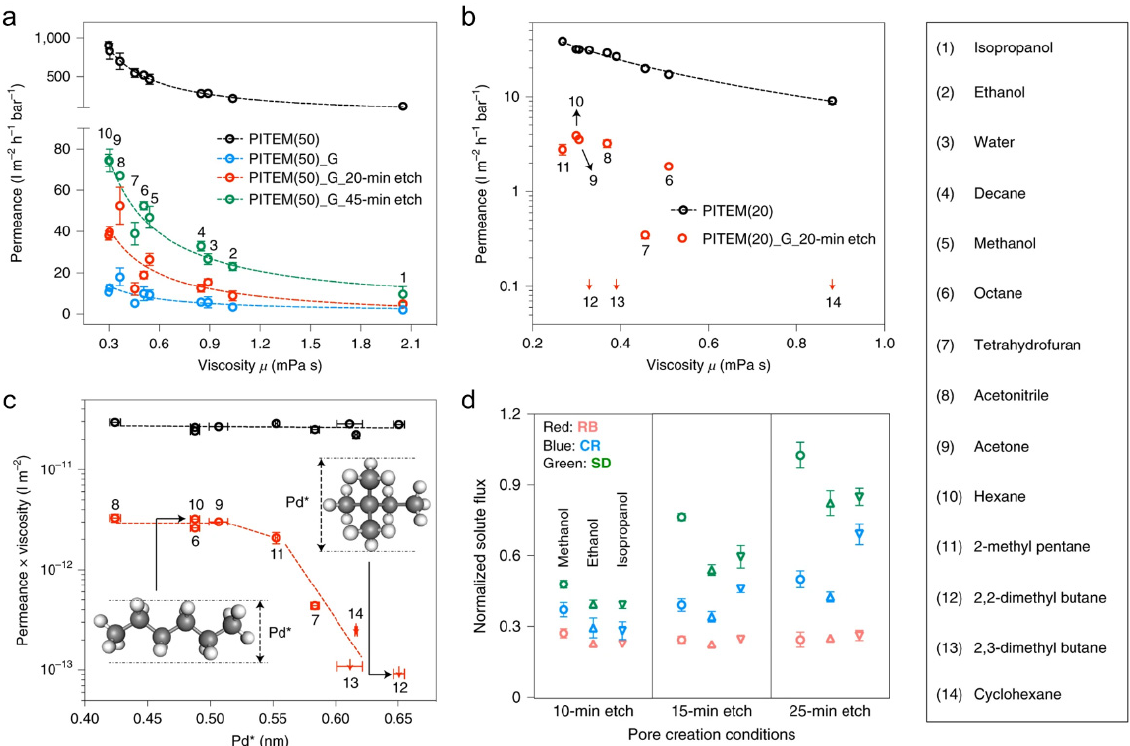
Figure 3. ( a , b ) Permeance–viscosity plot for nanoporous graphene membranes fabricated with various pore creation conditions and supported by PITEM (50 nm pore). ( a ) and PITEM (20 nm pore). ( b , c ) Dependence of the product of viscosity and permeance on the smallest permeable solvent diameter, Pd*, for PITEM (20)-supported membrane. ( d ) Selective solute diffusion for different-sized dye molecules depending on pore size [50]. Copyright 2021 Nature Publishing Group.